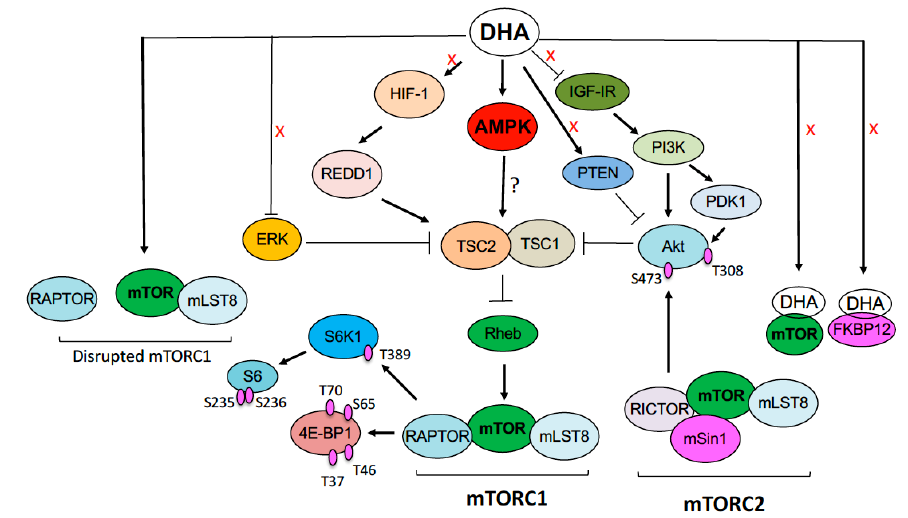
Figure 10. A proposed model of mTORC1 inhibition by DHA. DHA does not directly bind to mTOR or FKBP12. Besides, DHA alters neither the phosphorylation of IGF-IR/PI3K/Akt/PTEN and Erk1/2, nor the expression of HIF1 α /REDD1 in tumor cells. Instead, DHA inhibits mTORC1 by activating the AMPK pathway. In addition, DHA induces the dissociation of raptor from mTOR and inhibit the activity of mTORC1. Abbreviations: 4E-BP1, eukaryotic initiation factor 4E (eIF4E) binding protein 1; Akt, protein kinase B; AMPK, AMP-activated protein kinase; DHA, dihydroartemisinin; ERK, extracellular signal-regulated kinases; FKBP12, FK506 binding protein 12; HIF1, hypoxia-inducible factor 1; IGF-1R, insulin-like growth factor-1 receptor; mLST8, mammalian lethal with sec-13 protein 8; mSin1, mammalian stress-activated protein kinase- interacting protein 1; mTOR, mammalian target of rapamycin; mTORC1, mTOR complex 1; mTORC2, mTOR complex 2; PDK1, PI3K, phosphoinositide 3-kinase; PTEN, phosphatase and tensin homolog; RAPTOR, regulatory-associated protein of mTOR; REDD1, Rheb, Ras homolog enriched in brain; RICTOR, rapamycin-insensitive companion of mTOR; S, serine; S6, ribosomal protein S6; S6K1, p70 S6 kinase 1; T, threonine; TSC1, tuberous sclerosis complex 1; TSC2, tuberous sclerosis complex 2.